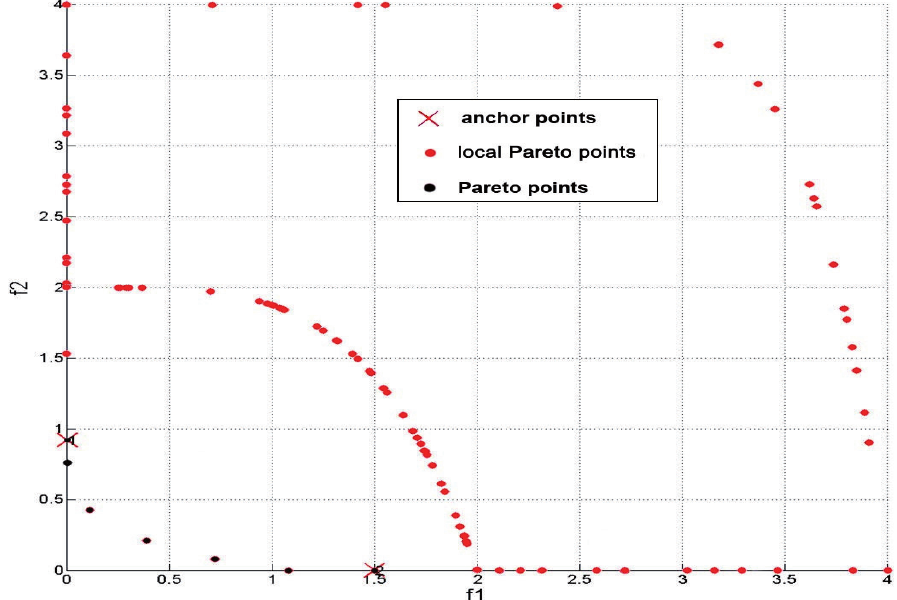
Fig. 9. Criterion